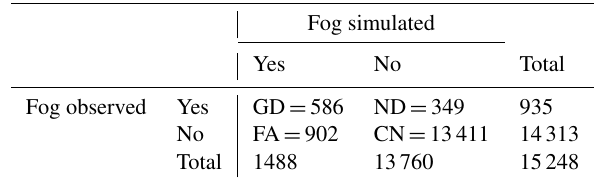
Table 4. Contingency table of fog profiles seen in the simulation and observations. Good detection (GD) occurs at the intersection of fog simulated and observed, false alarm (FA) is where fog is simulated but not observed, unpredicted (ND) is where fog is observed but not simulated, and correct negative (CN) is where fog is neither predicted nor